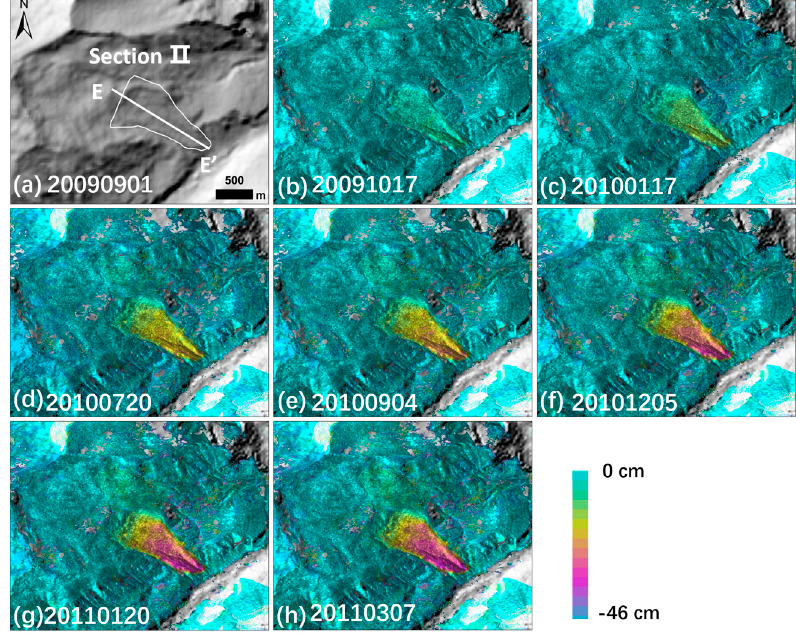
Figure 8. Time series deformation maps of the Jinpingzi landslide. The reference SAR acquisition date is 20090901.